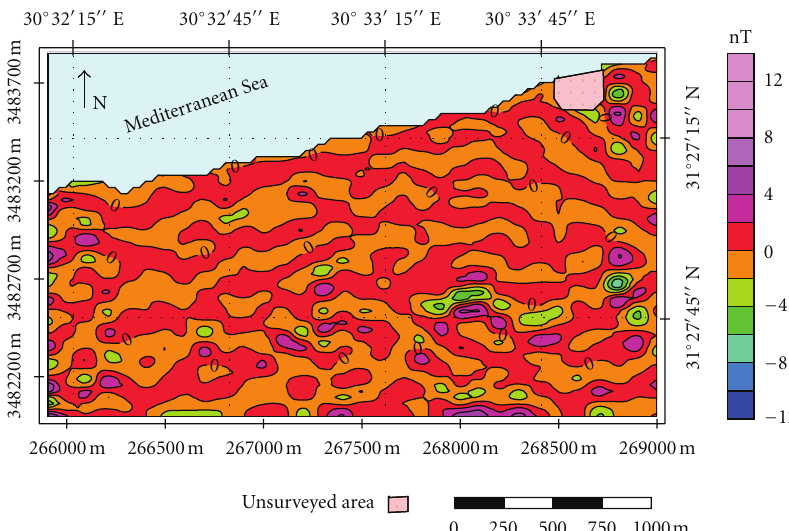
Figure 7: Filled colour contour map of the residual component of magnetic-field intensity of Koam Mashaal area, East Rosetta, Mediterranean Sea Coast, Northern Egypt at an average depth ( h ) of 57.9 m, contour interval = 2nT.